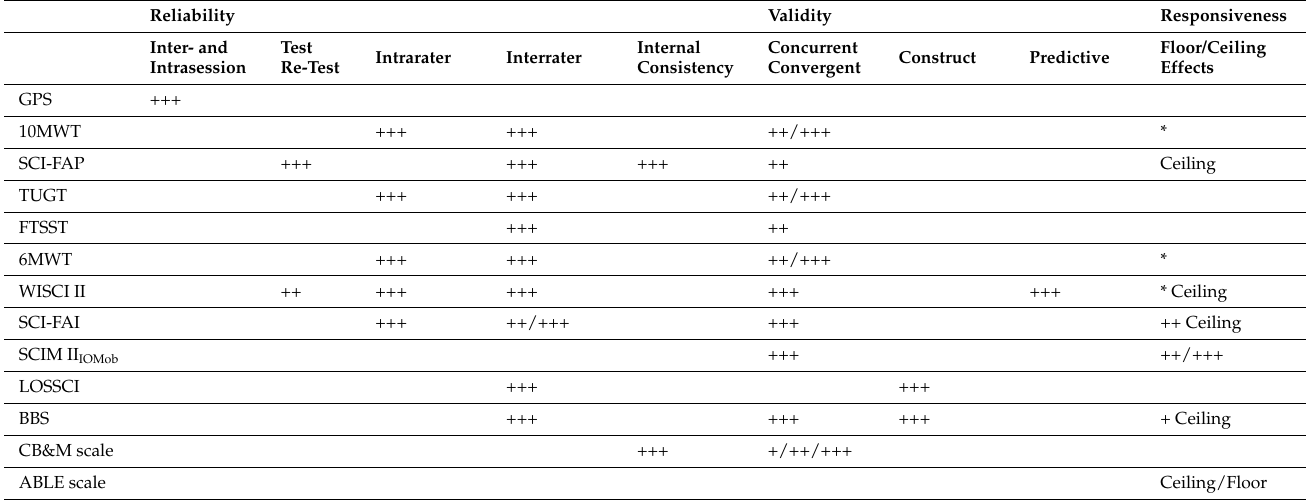
Table 4. Psychometric properties of walking ability outcome measures in